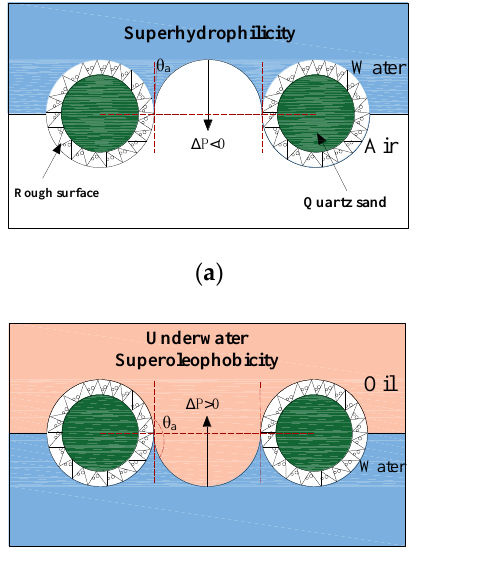
Figure 11. Intrusion pressure of CSQS.